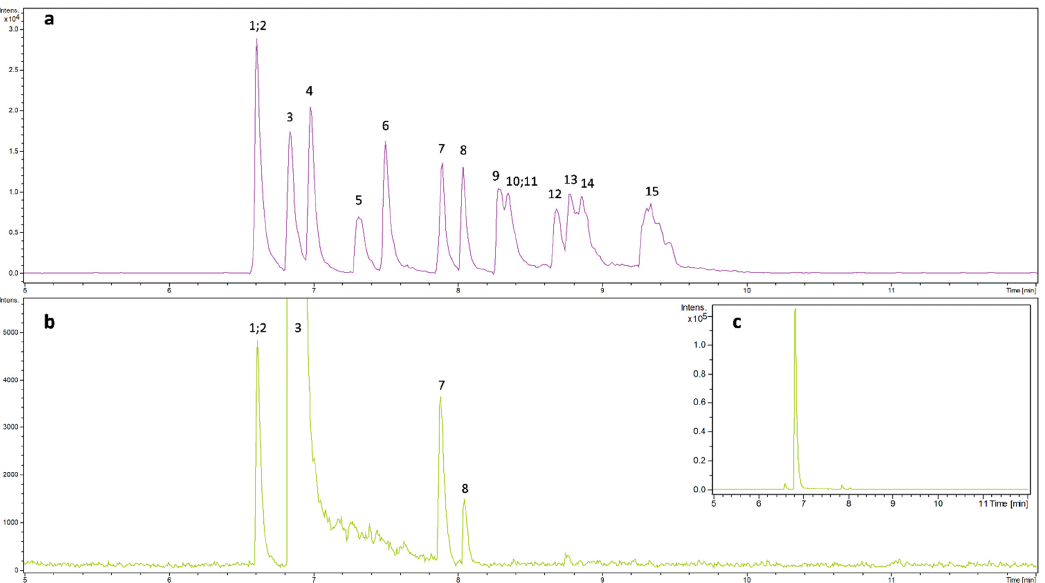
Figure 3. CZE-MS electropherograms obtained using 0.5 M NH 4 OH as BGE with ( a ) negative and ( b ) positive ionization mode. The inset ( c ) represents the electropherogram with a larger intensity scale in positive ionization mode. Conditions are the same as in Figure 2a, but for ( b , c ) the sheath liquid was 0.1% formic acid in IPA:water = 1:1 and the positive ionization mode was